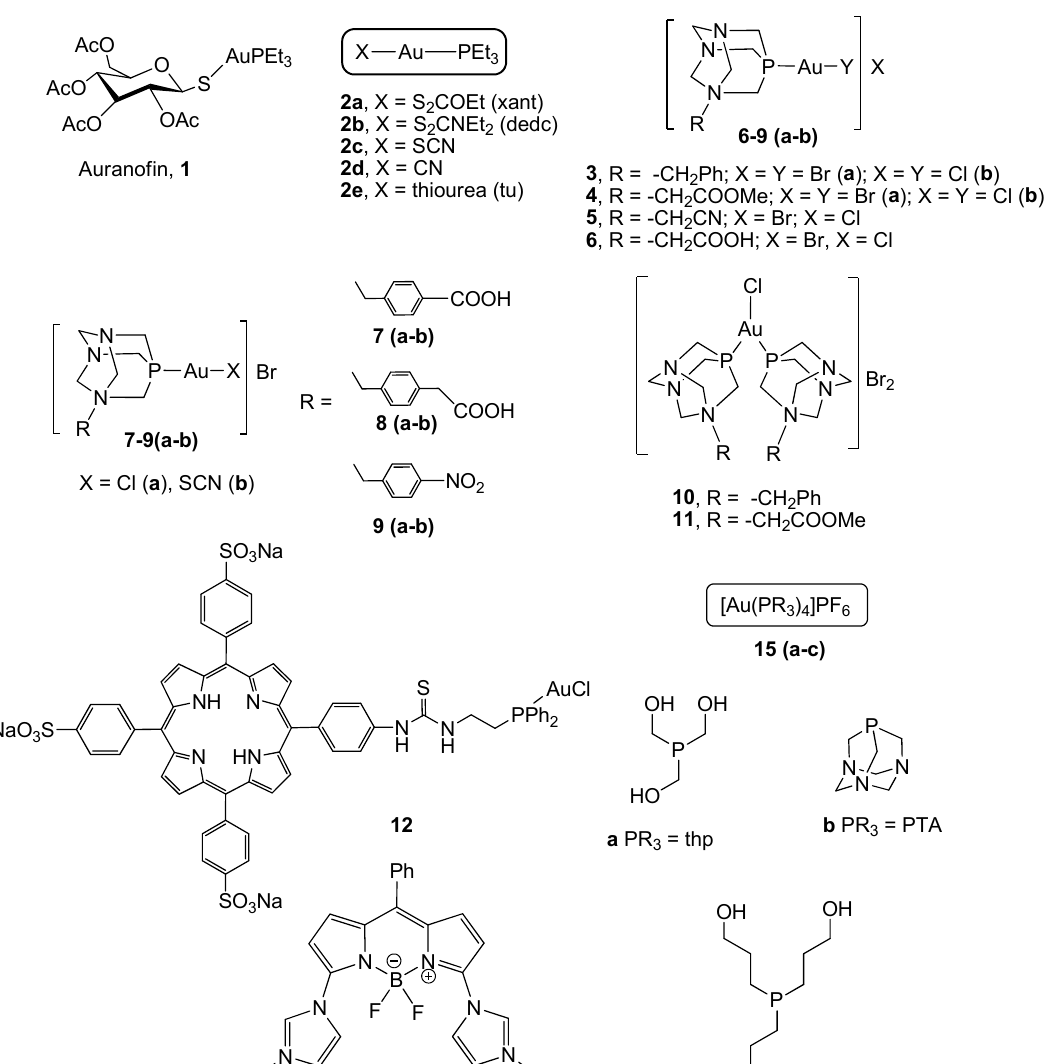
Figure 1. Gold(I) derivatives with monodentate